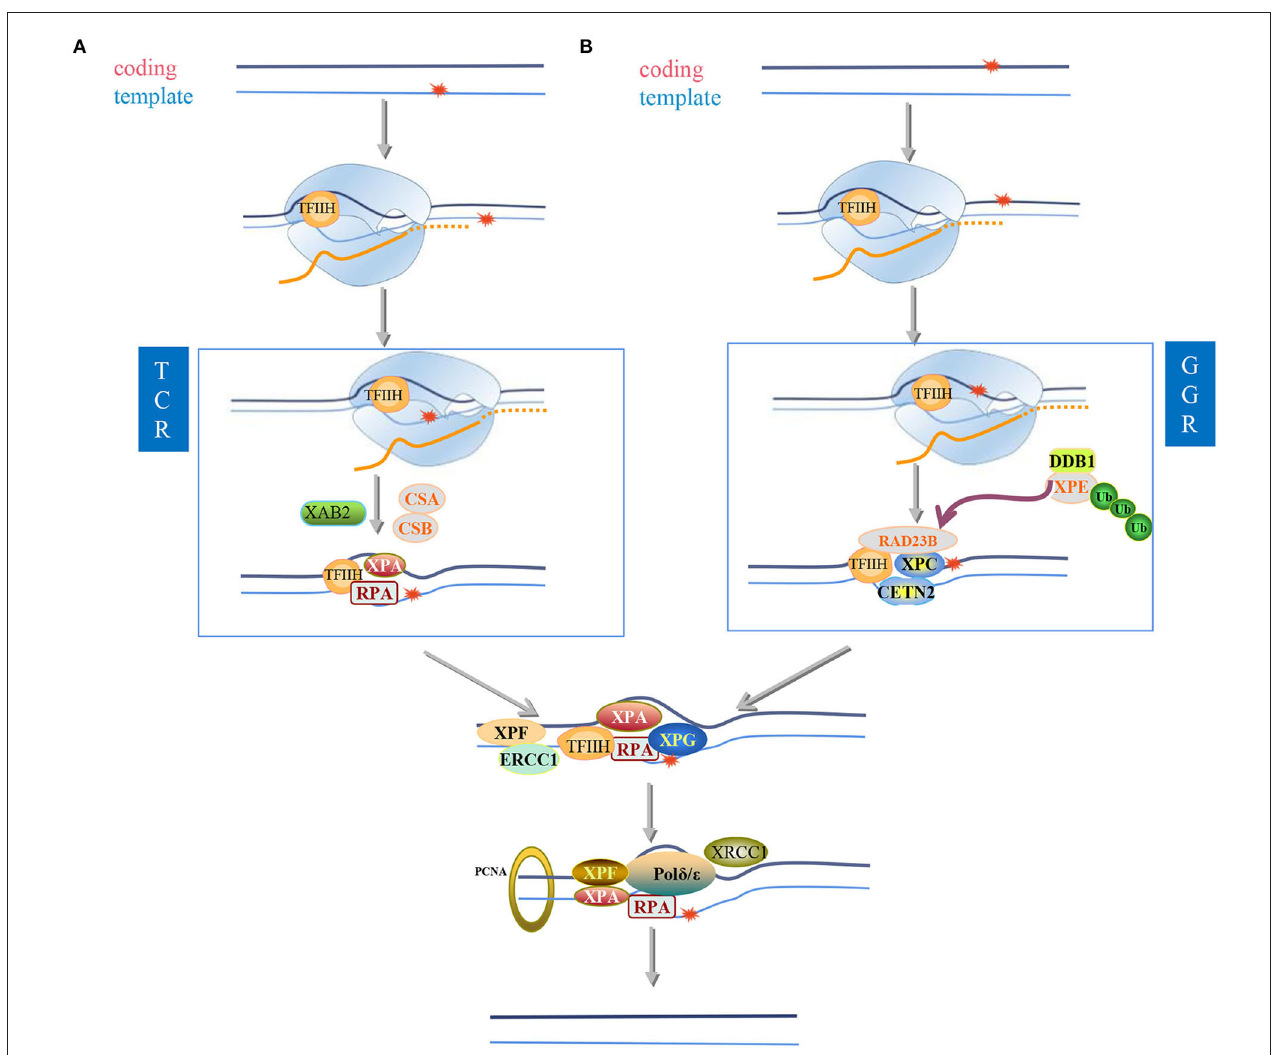
FIGURE 6 | Nucleotide excision repair. In eukaryotic cells exposed to ultraviolet radiation, two different nucleotide excision repair (NER) modes are activated: (I) transcription-coupled nucleotide excision repair) (TC-NER) and (II) global genome Nucleotide excision repair (GG-NER), which participates in the recognition of twisted DNA and determines preferences related to space and time. NER helps eliminate spiral twisting damage, including cyclobutane-pyrimidine dimers (CPD), 6-4 photoproducts (6-4PPs), and other bulky adducts; therefore, it maintains the stability of the genome. The predictive influence of NER subpathway on the coding or template damaged chain of actively transcribed genes. (A,B) are located on the template strand (A) or coding strand (B) of the active gene to repair bulky lesions. If the lesion is located on the template strand (A) , it is read by RNAPII during the transcription process, and the lesion will cause the RNAPII complex to stall. CSA and CSB proteins are sensors of stalled RNAPII and recruit the transcription complex TFIIH to the lesion. The helicase activity XPB and XPD of the TFIIH complex open the chromatin around the lesion. XPA and RPA stabilize the open structure of chromatin. Endonuclease, ERCC1-XPF in 5’and XPG in 3’cut the damaged chain. Then, the gap is filled by DNA repair polymerase and ligase. If the lesion is located on the coding strand (B) and therefore cannot be read by the RNAPII complex, the lesion will not interfere with the synthesis of the enzyme and the gene will be transcribed. The lesion can be identified by the XPC complex in the future. TFIIH opens a denatured bubble of about 30 nucleotides around the lesion. The complex of XPC, RAD23B, and CETN2 can directly bind to the opposite DNA strand, where the spirally twisted lesion accumulates XPC is recruited to these damaged sites only after the UV-DDB (ultraviolet-damaged DNA-binding protein) complex binds. XPC complex is a disease-binding protein in global genome repair (GG-NER). After the DNA helix is partially opened, RPA (replication protein A) is added to the complex, which then helps in damage verification. XPA is best combined with single-stranded DNA (double-stranded DNA) structure, while RPA can only be observed in the ssDNA (single-stranded DNA region. This is the second NER subpathway. After the lesion recognition step, GG-NER and TC-NER are the same in the air bubbles before the incision, XPA has been shown to be located on the 5’side of the lesion. XPF-ERCC1 catalyzes the 5’incision, and XPG is responsible for the 3’incision around the lesion. ERCC1 is polyubiquitinated at the K33 site, which can be It is removed by USP45 (ubiquitin-specific peptidase 45). In TC-NER, when RNA polymerase II stays on the lesion during the transcription extension process, the lesion is recognized. RNA polymerase II (RNAPII) is due to active genes. The damage in the transcription chain (TS) stalls and attracts NER enzymes, RNAPII (RNA polymerase II), and CSB (Cockayne syndrome B protein) to further repair the protein. It can be deubiquitinated by USP7 to keep recruited in the lesion. Proliferating cell nuclear antigen (PCNA) is loaded to the 5’end of the DNA. PCNA interacts with XPA and XPF to stimulate their activity. The DNA region containing 22–30 nucleotides is excised from the complex DNA with TFIIH and then slowly released from TFIIH, bound by RPA or degraded by nuclease. During the nicking step, XPG is simultaneously ubiquitinated by CRL4Cdt2 and then degraded in the 26S proteasome. DNA synthesis is catalyzed by DNA polymerase δ / ε . Precise coordination of ubiquitin-mediated RNAPII removal after transcriptional blockade.